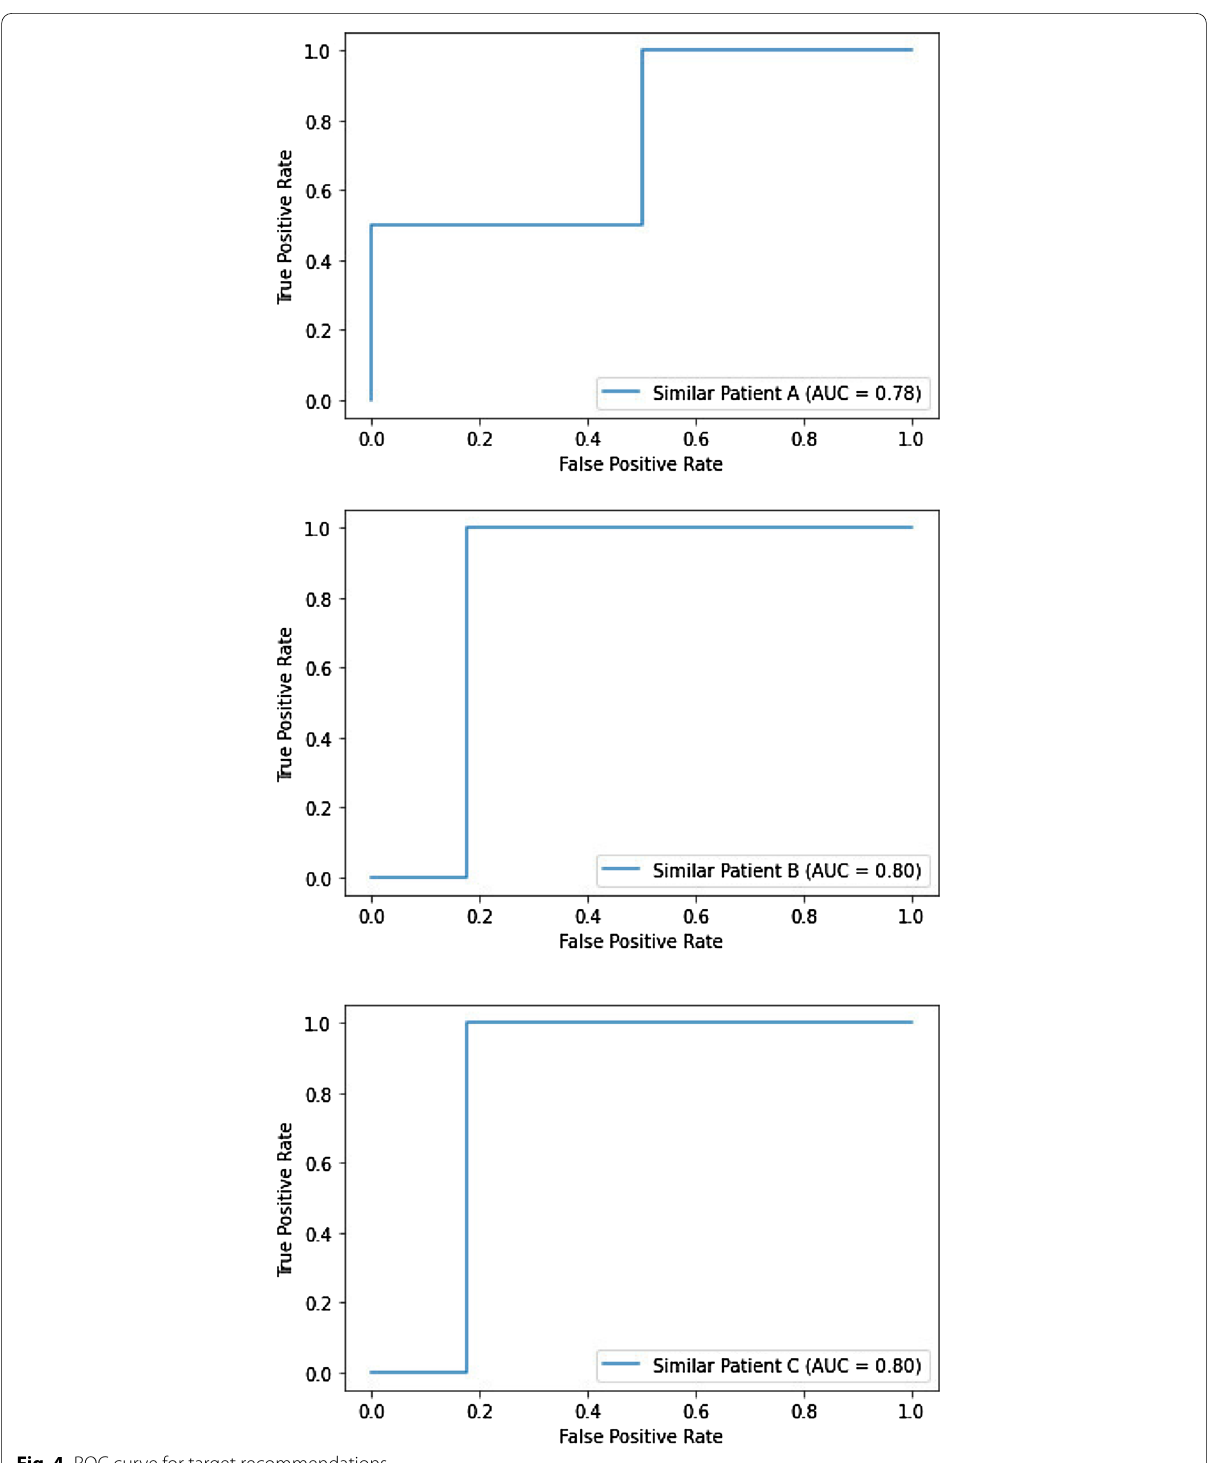
Fig. 4 ROC curve for target